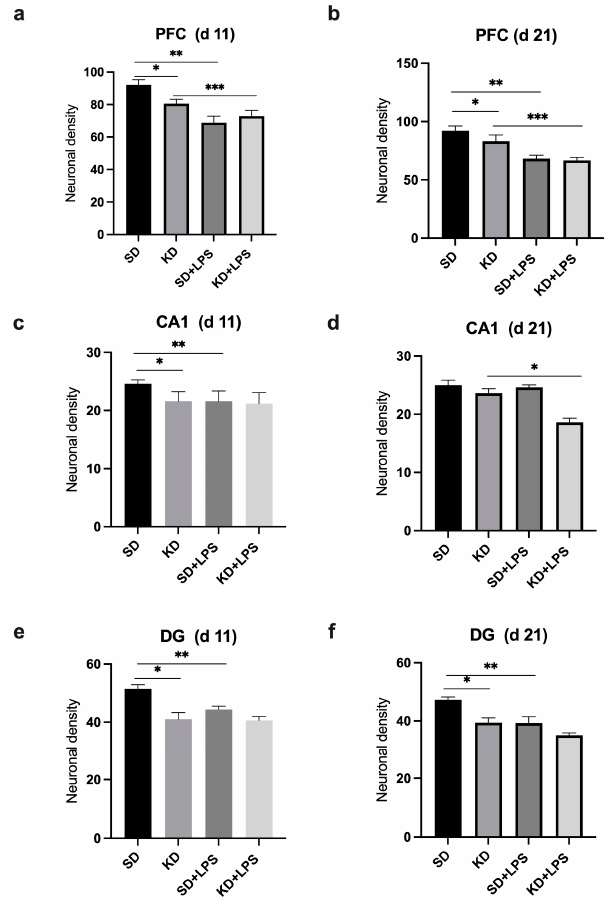
Figure 3. Comparison of neuronal densities in the prefrontal cortex (PFC), CA1 and dentate gyrus (DG) regions at postnatal days PN11 and PN21. *, **, *** p < 0.05 . Neuronal density in the PFC ( a ), CA1 ( c ) and DG ( e ) regions were found to be lower in the KD group when compared to the SD group at PN11 and neuronal density in the PFC ( b ), CA1( d ) and DG ( f ) regions were found to be lower in the KD group at PN21.